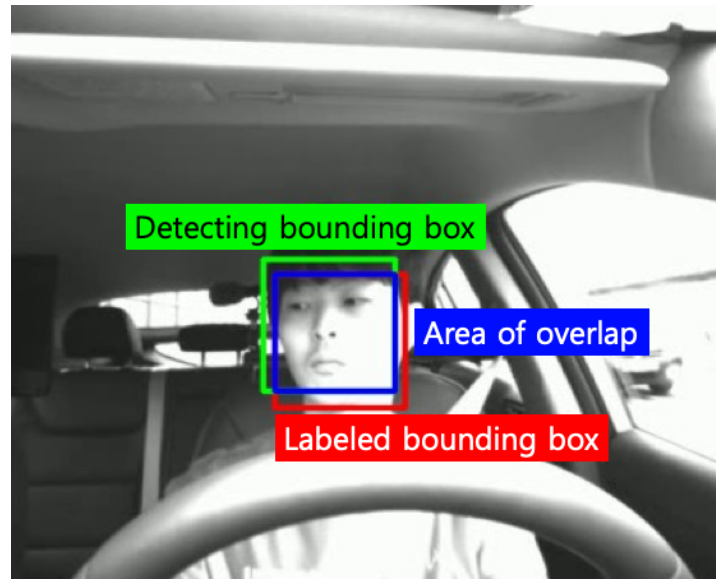
Figure 10. Example image with IoU of 0.68. Area of union (green and red) is 7441, and area of overlap (blue) is